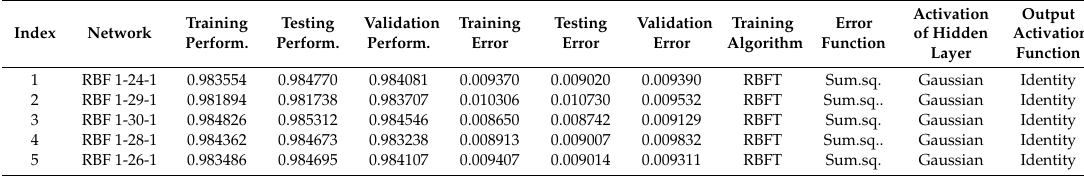
Table 2. Overview of retained neural